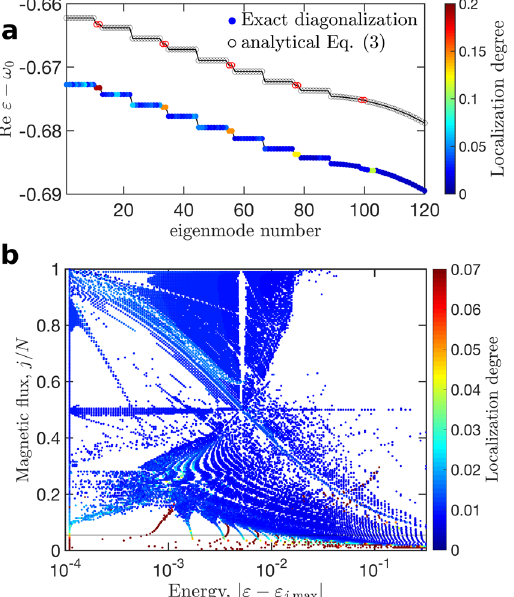
Fig. 3 Self-induced Hofstadter butter fl y. a Energy spectrum for the two-polariton states in the group of states corresponding to j = 11, calculated from the approximate Eq. (3) and by the exact diagonalization of the two-particle Hamiltonian Eq. (1). b Butter fl y energy spectrum obtained by the exact diagonalization as a function of group number j , determining the effective magnetic fi eld. Localization degree is determined as the inverse participation ratio of the vector χ in Eq. (2) and is shown by color. Thin horizontal line in b indicates magnetic fi eld j / N = 11/200, corresponding to panel a . Calculation has been performed for N = 200 and φ = 0.02, energy is measured in the units of Γ 0